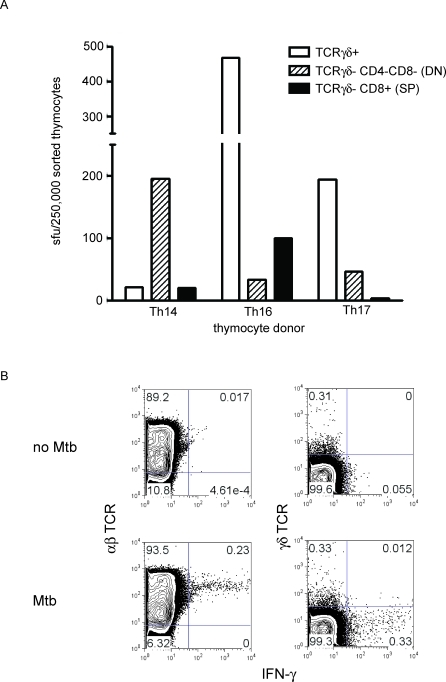
The Majority of Mtb-Reactive Thymocytes Are αβTCR+ T Cells, While a Minority Express the γδTCR(A) Thymocytes from 3 random donors were stained with the following fluorochrome-conjugated antibodies: CD4-PE, CD8-APC, γδTCR-FITC. CD4-negative subsets (γδTCR+; γδTCR− CD8+; γδTCR− CD8−) were collected by FACS. Cell subsets were incubated with Mtb-infected DC or uninfected DC in an IFN-γ ELISPOT assay and the response to Mtb-infected DC is shown. No responses to uninfected DC were detected.(B) Unfractionated thymocytes (500,000 cells/well) were incubated with either uninfected or Mtb-infected DC (50,000 cells/well) and IFN-γ production was detected using the ICS assay. Cells were fixed and permeabilized and stained with fluorochrome-conjugated antibodies to label the following: γδTCR, αβTCR, IFN-γ, and CD3. All cells depicted in (B) are CD3+. Similar results were obtained from 3 separate donors.